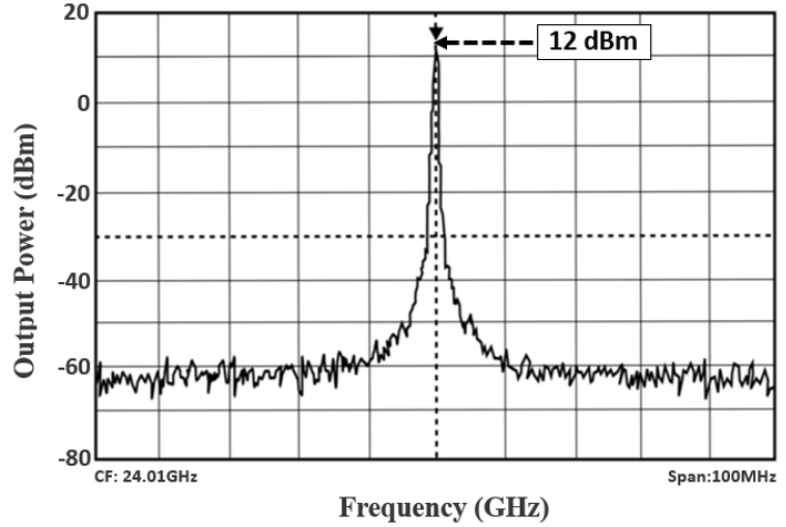
Figure 13. Measured output power spectrum of the VCO.